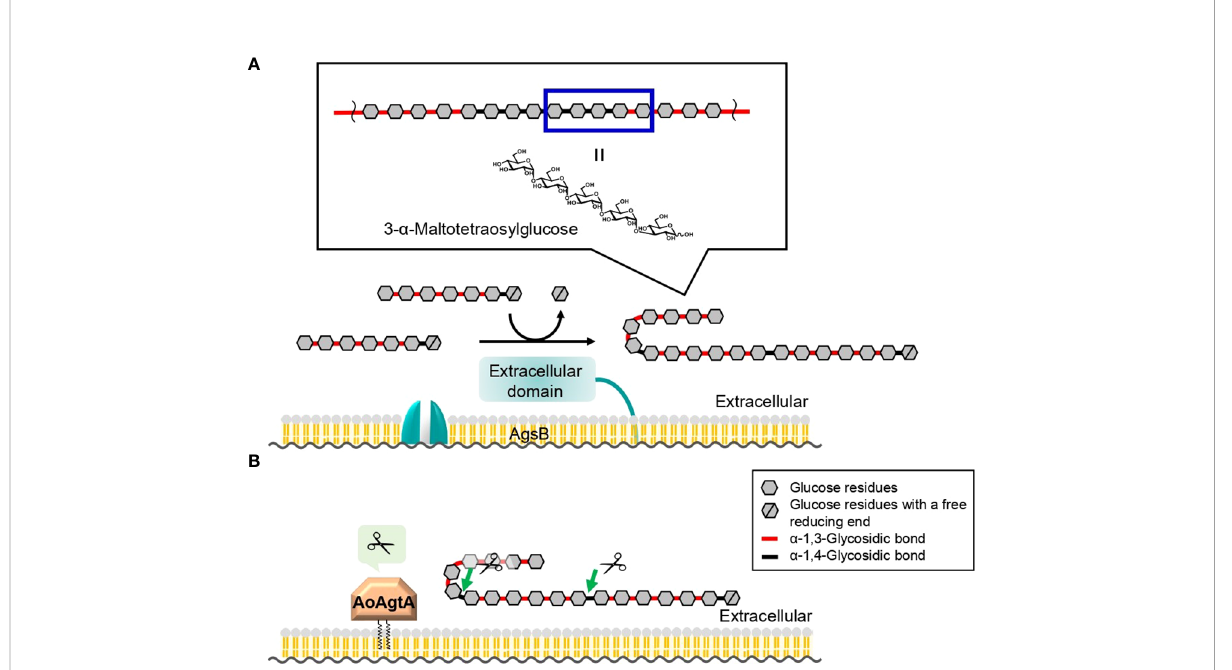
FIGURE 7 Predicted role of AoAgtA in cell wall a -1,3-glucan biosynthesis in A . oryzae . (A) During biosynthesis, a -1,3-glucan subunits may be interconnected by transglycosylation catalyzed by the extracellular domain of AgsB; the structure of 3- a -maltotetraosylglucose is consistent with the structure in which a -1,3-glucan subunits are linked. (B) We speculate that AoAgtA cleaves the spacers composed of a -1,4-linked glucose residues in cell wall a -1,3-glucan before its